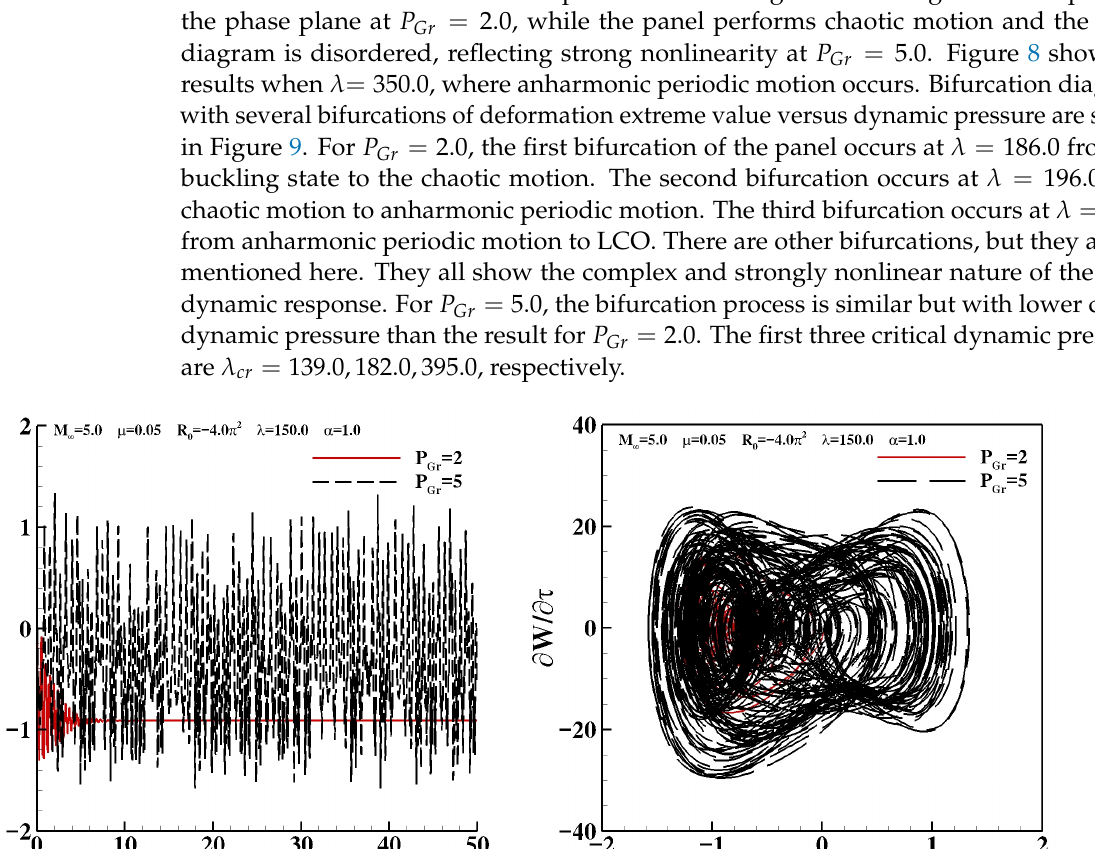
Figure 7. ( a ) Time history and ( b ) phase diagram under different pressure drop ratios ( λ = 150.0).